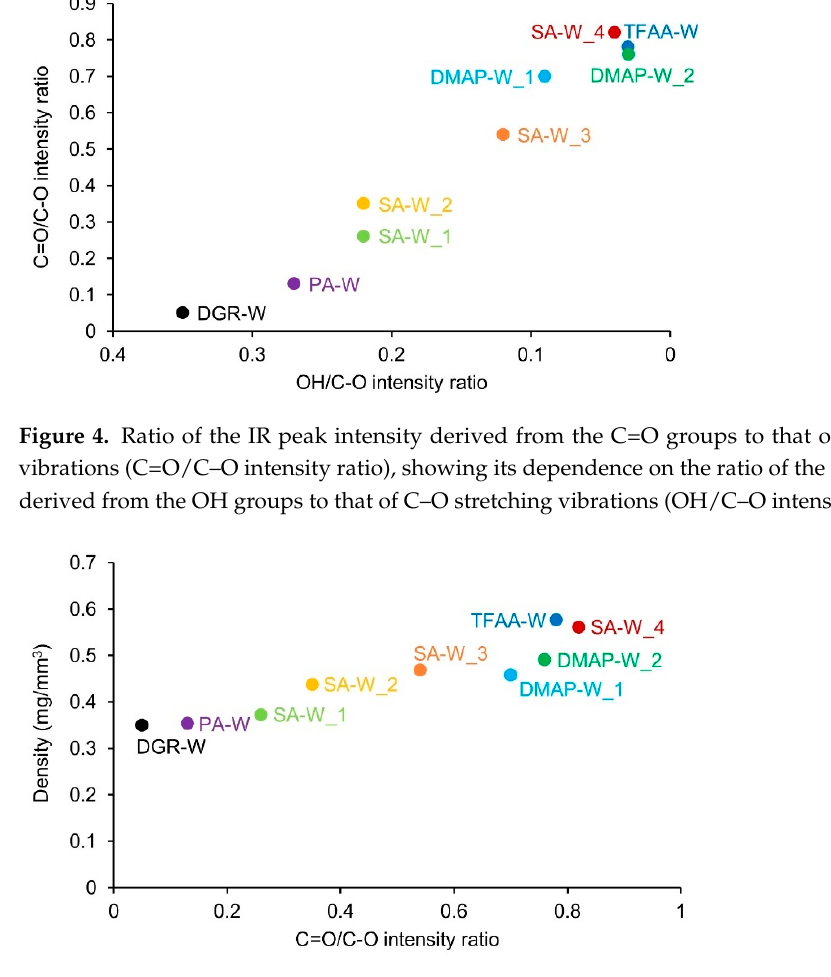
Figure 5. Density of the wood specimens, showing the ratio of the IR peak intensity derived from the C=O groups to that of C–O stretching vibrations.